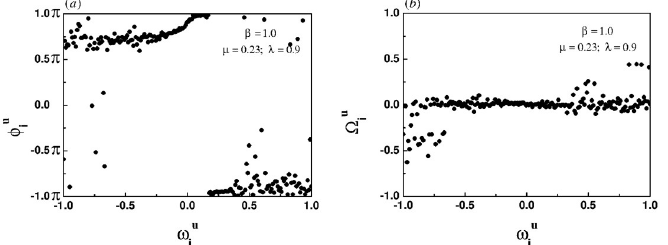
Fig 4. Snapshots of the instantaneous phases (left panel) and the effective frequencies (right panel) for the linear correlation when the intra-layer and inter-layer coupling strength are set to 0.23 and 0.9, respectively.